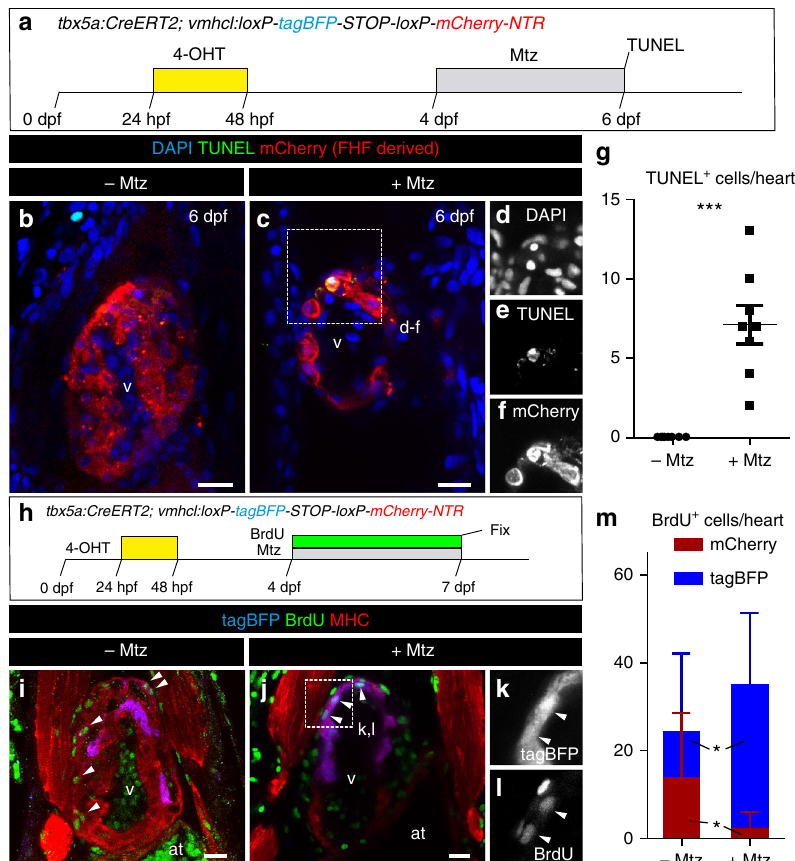
Fig. 5 Apoptosis and cell proliferation upon genetic ablation of tbx5a -derived ventricular cardiomyocytes. a tbx5a + ventricular cardiomyocytes